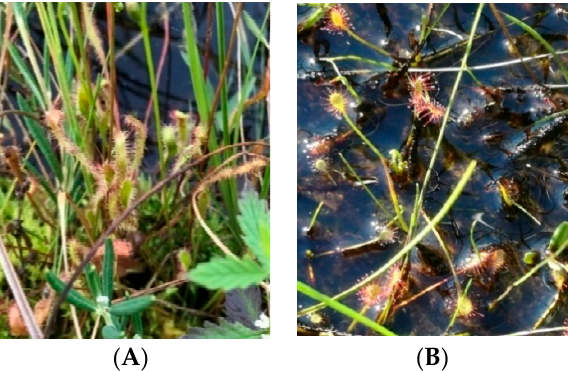
Figure 1. Intermediate sundew ( A ), long-leaved sundew, ( B ) position by Lake Ł ukietek .